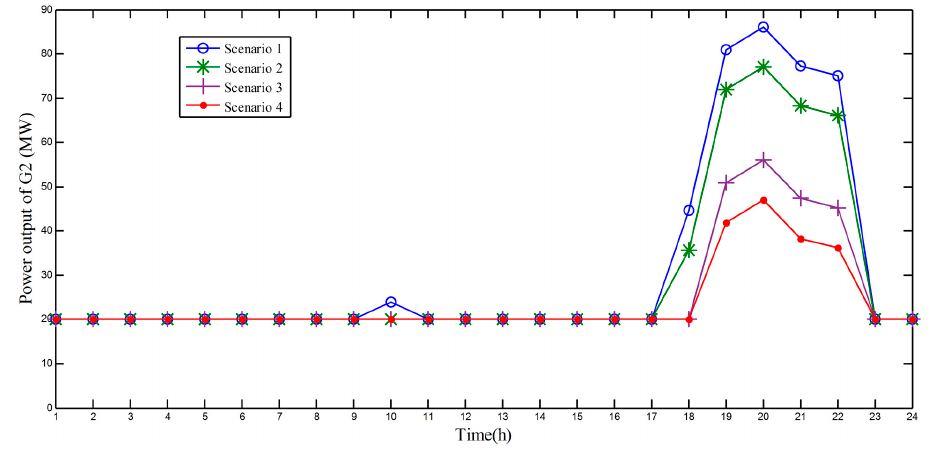
Figure 11. The power outputs of G2 in four scenarios.